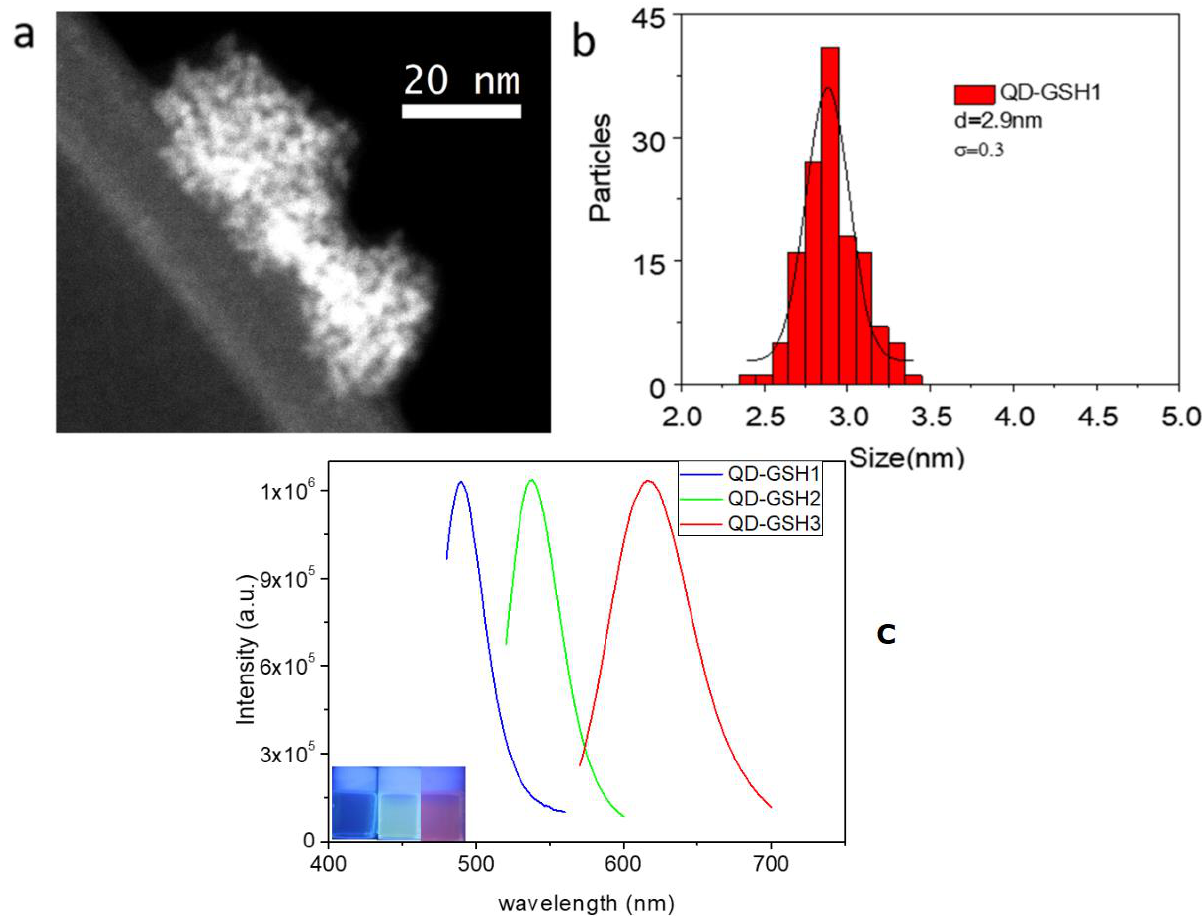
Figure 4. HAADF image ( a ), as well as the histogram displaying particle size distribution ( b ) of quantum dot (QD)-GSH1 NPs. ( c ) PL-emission spectra for QD-GSH1 (blue) as well as for QD-GSH2 (green) and QD-GSH3 (red), with higher average size. The inset in this figure shows a digital photo image of the three QD-GSH colloidal solutions used in this figure, under UV irradiation.